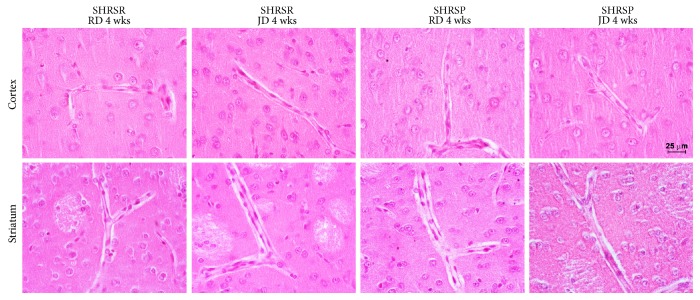
Brain histological analysis of SHRSP and SHRSR at the end of 4 weeks of either JD or RD treatment. Representative images of cortical (cortex) and striatal (striatum) blood vessels in the two strains at the end of 4 weeks of either RD or JD treatment. JD = high-salt Japanese style diet; RD = regular diet.